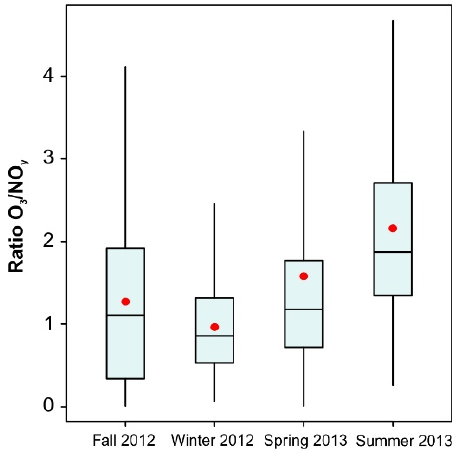
Figure 8. O 3 /NO y ratios by season derived from observations made at the OBI site during September 2012–August 2013. Ratios below six are typical of VOC-sensitive regimes.